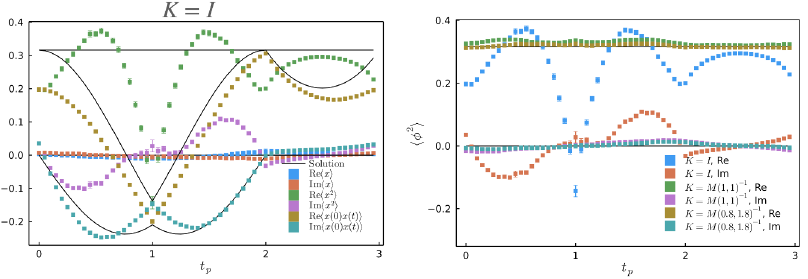
Figure 2. (left) The CL dynamics of the strongly coupled anharmonic oscillator on the SK contour with real-time extent mt max = 1 in the absence of a kernel. Note the incorrect convergence in all observables. (right) Same system after introducing the manually constructed kernel of eq.